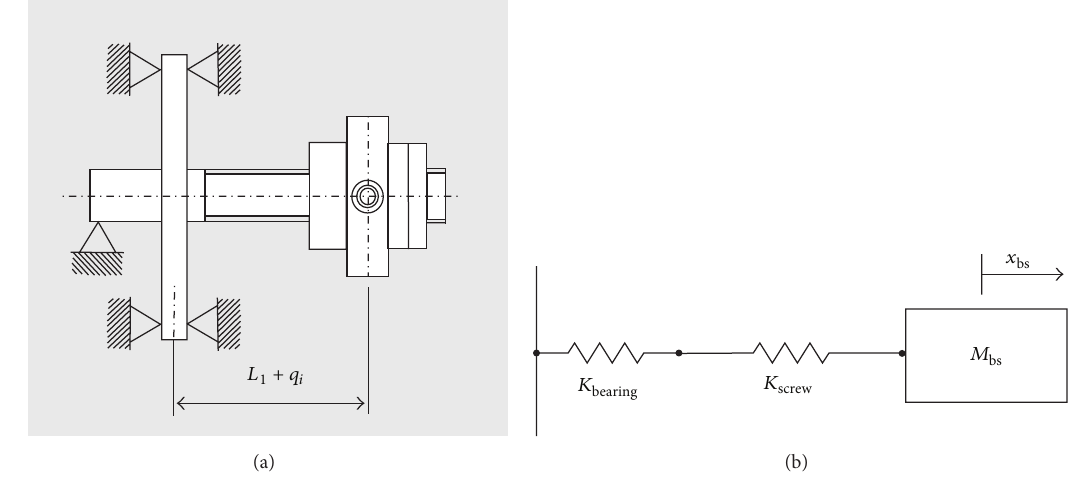
Figure 4: (a) Ball-screw shaft free at one end and (b) mass-spring model of the axial deformation of the ball-screw.